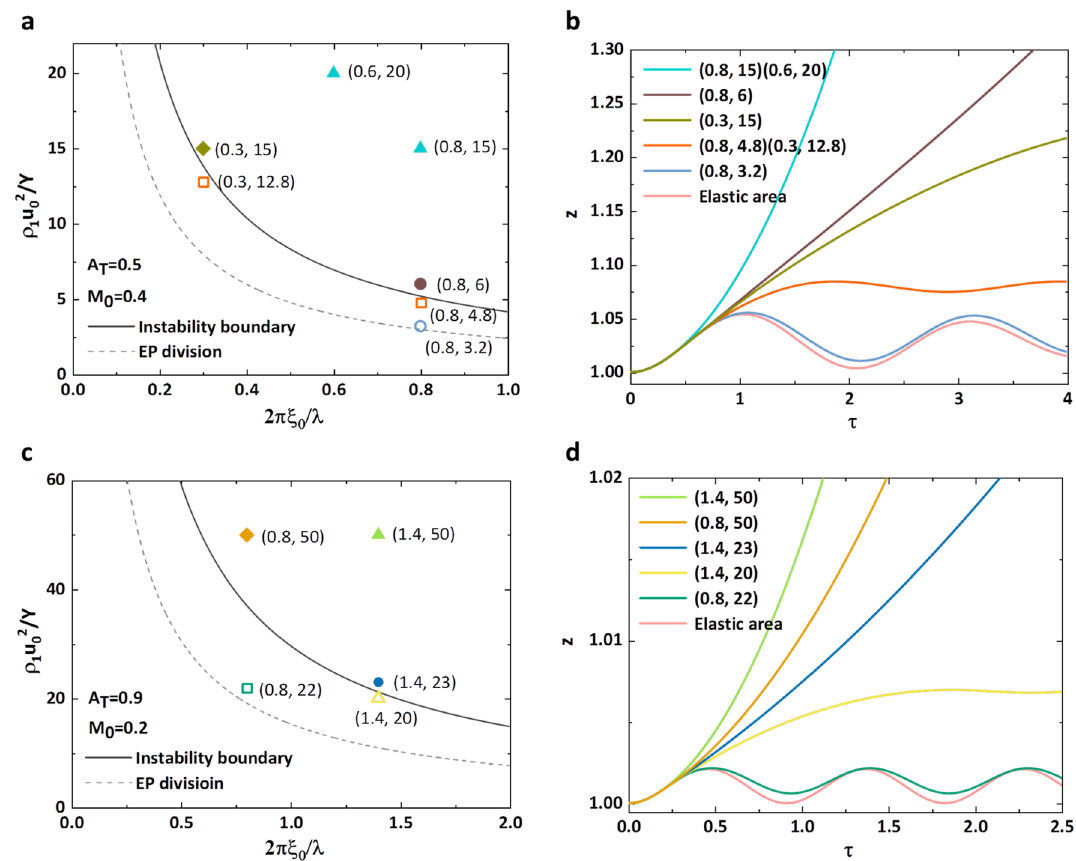
Figure 4. Two groups of instability boundary, EP division and growth factor by theory. ( a , b ) The first group of instability boundary, EP division and growth factor for arbitrarily picked points with A T = 0.5, M 0 = 0.4. ( c , d ) The second group with A T = 0.9, M 0 = 0.2. The solid points meaning picked variable combinations locate above instability boundary, and the hollow points are between instability boundary and EP division. of each point are marked in bracket after point. Some of them have the same points with the same shape and color, their ( d ) figures are completely the same as point color. The line labeled as "Elastic area" is the growth factor for the region beneath EP division, and other lines are labeled with corresponding